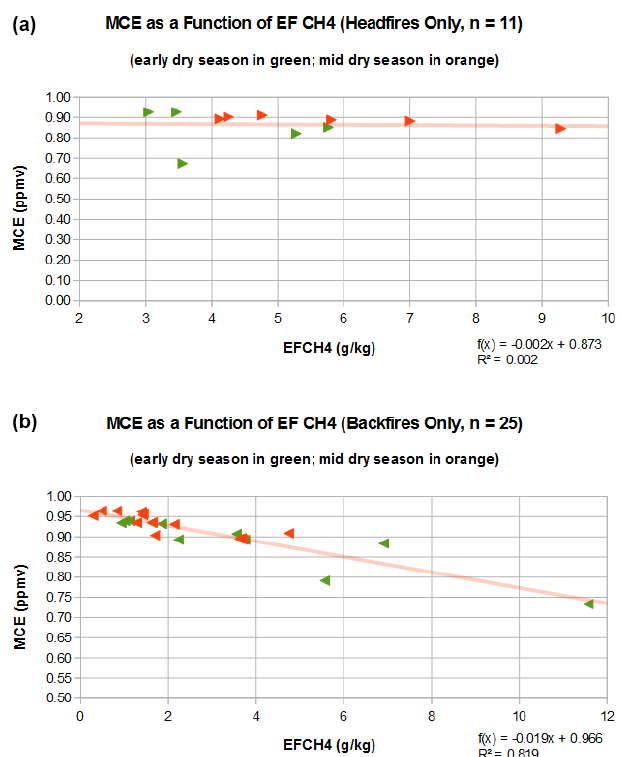
Figure 6. MCE as a function of CH 4 EF for head fires (a) and back- fires (b) . Green fires are EDS, and orange are MDS. Arrows indicate fire type (2014–2016, Mali).